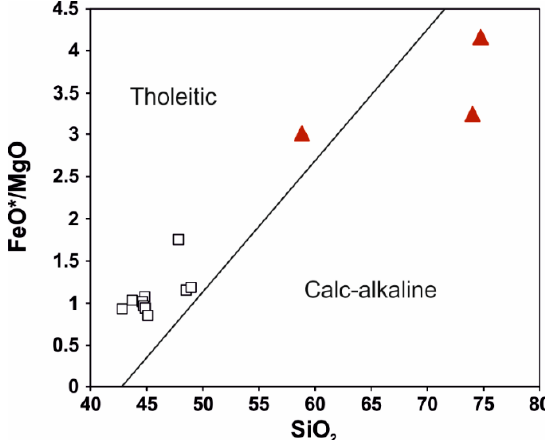
Figure 7. FeO*/MgO vs SiO 2 diagram from [46] for the mafic and intermediate-felsic rocks. Symbols - ref. Figure 6. FeO* is total iron .